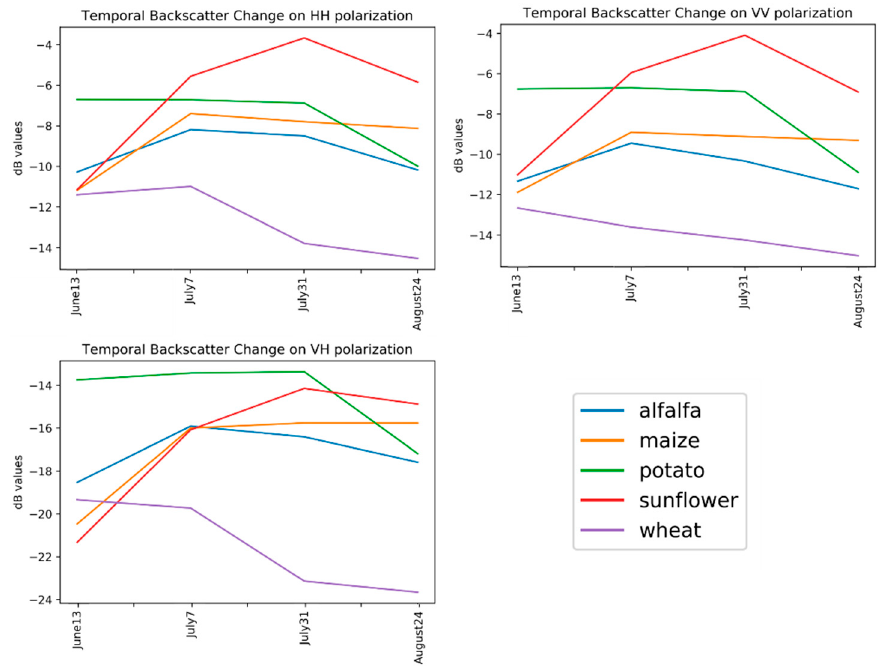
Figure 6. Temporal backscatter changes on polarizations.